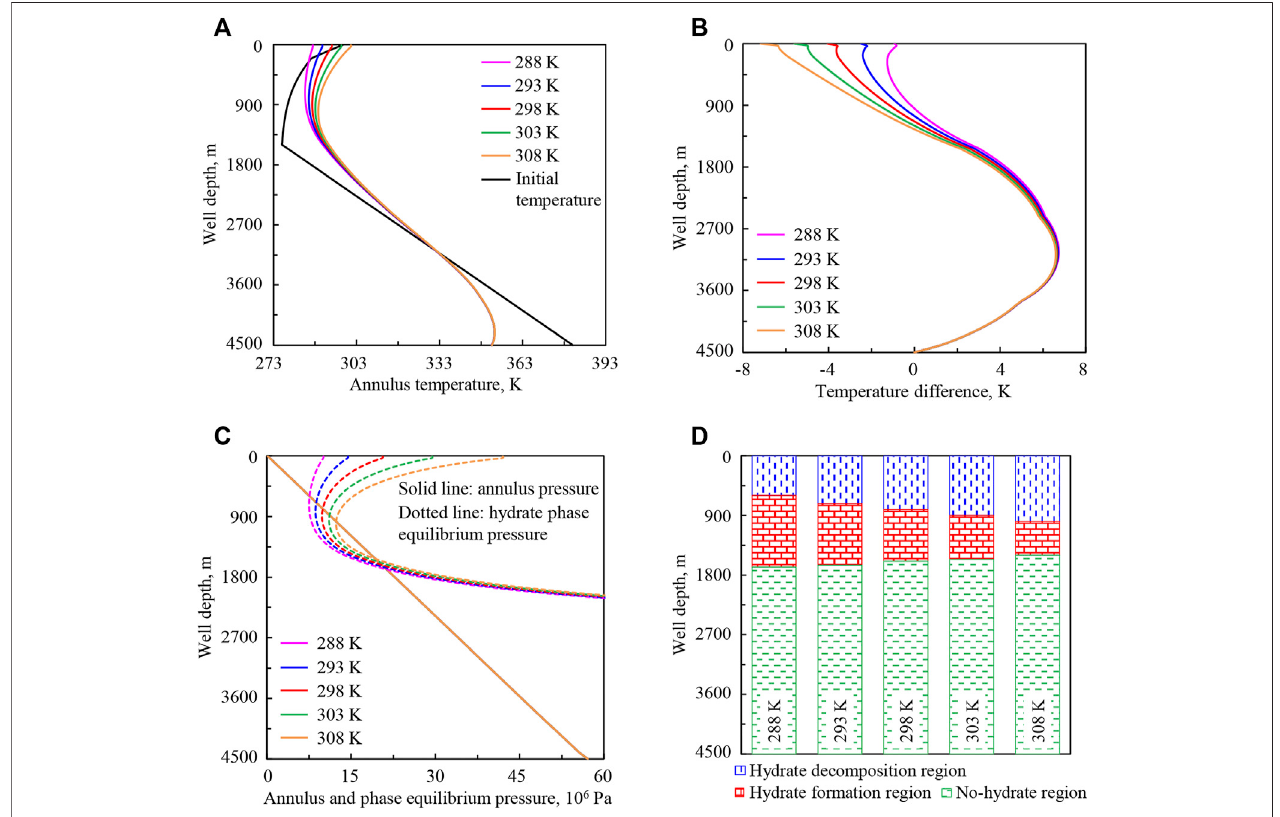
FIGURE9| Variationregularitiesofwellboretemperature fi eld,pressure fi eld,andhydrateformationregionindeep-waterdrillingunderdifferentdrilling fl uidinjection temperatures: (A) annulus temperature, (B) temperature difference between the drilling fl uid in the annulus and in the drill string, (C) annulus pressure and phase equilibrium pressure, (D) hydrate formation region. The solid lines under different drilling fl uid injection temperatures in (C) are